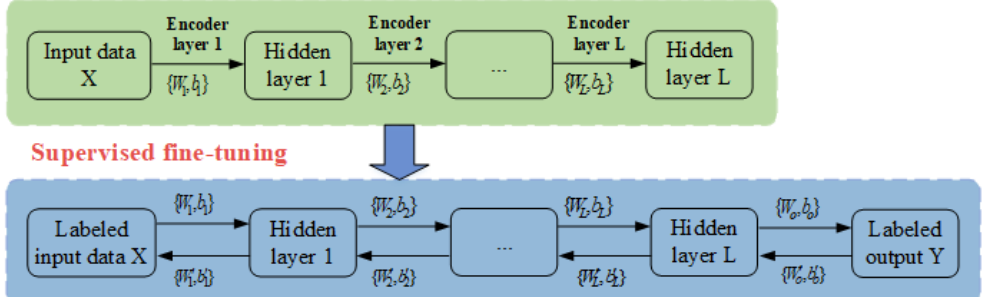
Figure 5. Training procedure of an SAE.